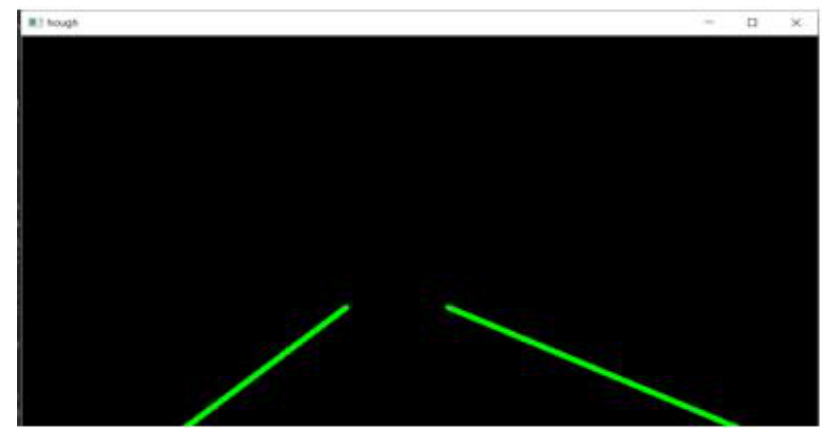
Figure 2. Canny edge detection and establishing the ROI.